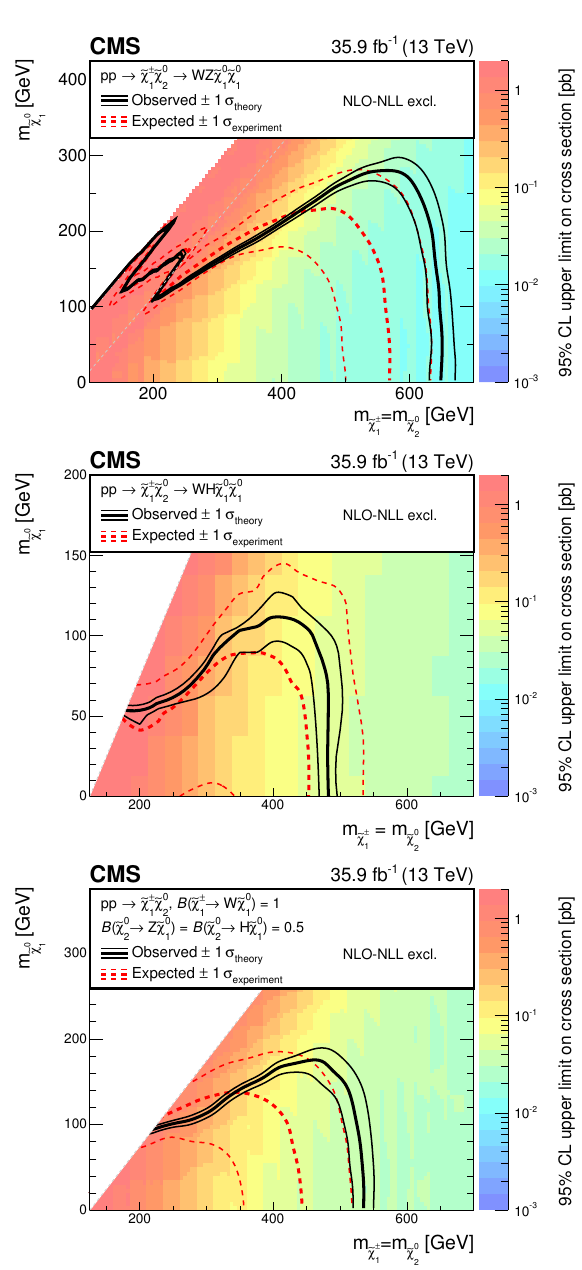
Figure 8 . The 95% CL upper limits on the production cross sections in the plane of m for the models of (cid:31) (cid:6) (cid:31) 0 production with (upper) the WZ topology, (middle) the WH topology, or 2 1 (lower) the mixed topology with 50% branching fraction to each of WZ and WH. The thick solid black (dashed red) curve represents the observed (expected) exclusion contour assuming the theory e e cross sections. The area below each curve is the excluded region. The thin dashed red lines indicate the (cid:6) 1 (cid:27) experiment uncertainty. The thin black lines show the e(cid:11)ect of the theoretical uncertainties ( (cid:6) 1 (cid:27) theory ) on the signal cross section. The color scale shows the observed limit at 95% CL on the signal production cross